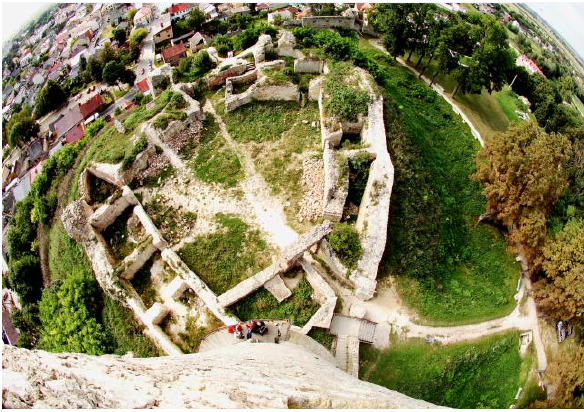
Figure 1. Castle ruins – view form the top of the tower